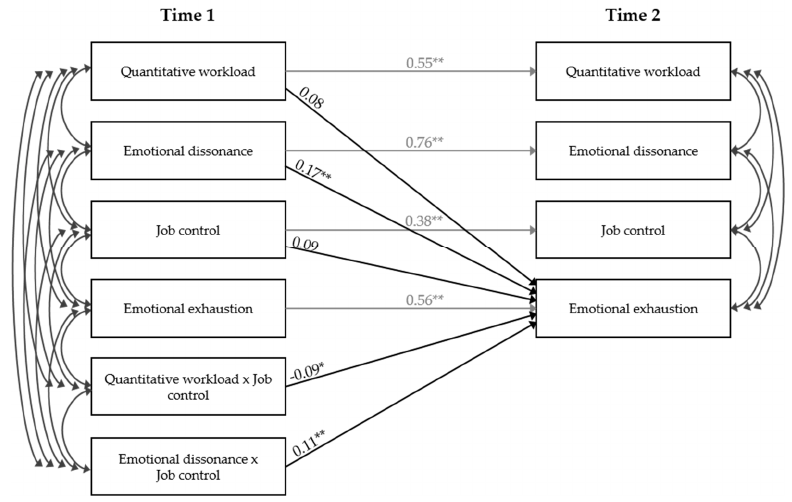
Figure 1. Parameter estimates of Model 5 (moderation model); black paths represent causation paths,